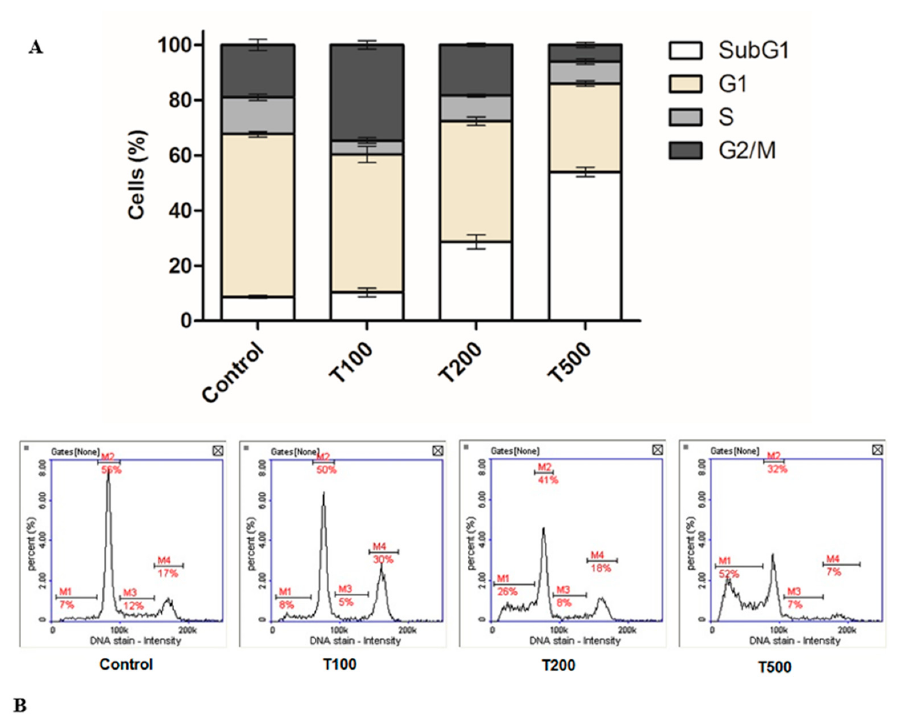
Figure 5. ( A ) Cell cycle analysis by image cytometry. The results were calculated as % of control values which were averaged to define the 100%. The RPMI 8226 cells were treated with Teriflunomide (T) (100–500 µM) or DMSO as vehicle in control cultures for 24 h. Values were presented as mean ± SD derived from three independent experiments. ( B ) Representative histograms (M1-4: cell cycle phases subG1, G1, S, G2/M, respectively).